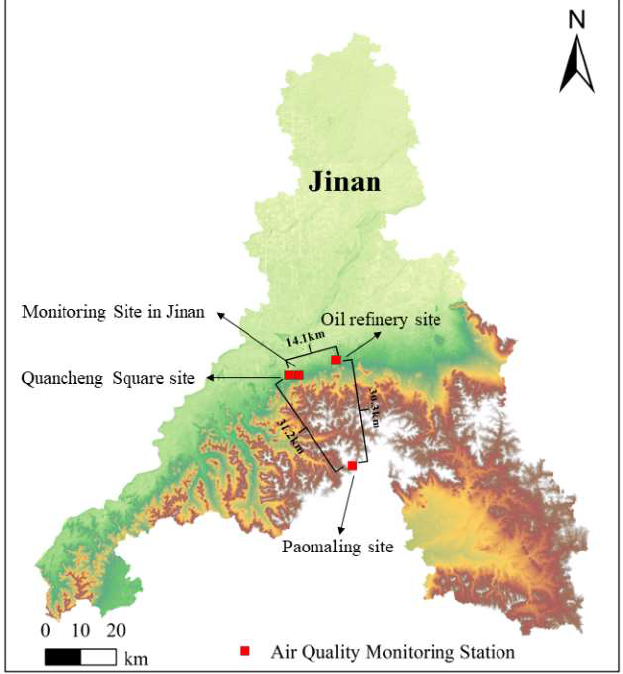
Figure 1. A map of Jinan showing the location of the air quality monitoring stations. The VOC species were detected and analyzed by GC-MS/FID, including 107 com- ponents of PAMS and TO-15. The MS and QCS adopted the Shanghai Panhe automatic monitor for VOCs; OL and PML adopted the Wuhan Tianhong automatic monitor for VOCs. For each sample analysis, four internal standard compounds (i.e., bromochloromethane, 1,4-difluorobenzene, deuterated chlorobenzene, and 4-bromofluorobenzene) were used for an internal standard method of quantification. The quantitative calibration curve gradient was 0.5, 1.0, 2.0, 5, 15, and 20 ppbv linear regression acquisition. The middle point of the curve was calibrated once every morning to ensure that the deviation was not greater than 30%, otherwise, the standard curve was redrawn for calibration. The conventional pollutants (i.e., SO 2 , NO 2 , CO, O 3 , PM 2.5 , and PM 10 ) and meteorological parameters (i.e., wind direction, wind speed, temperature, humidity, and atmospheric pressure) were ob- tained from the site’s automatic monitoring network data. The monitoring equipment was automatically calibrated every morning. All monitoring data were updated every